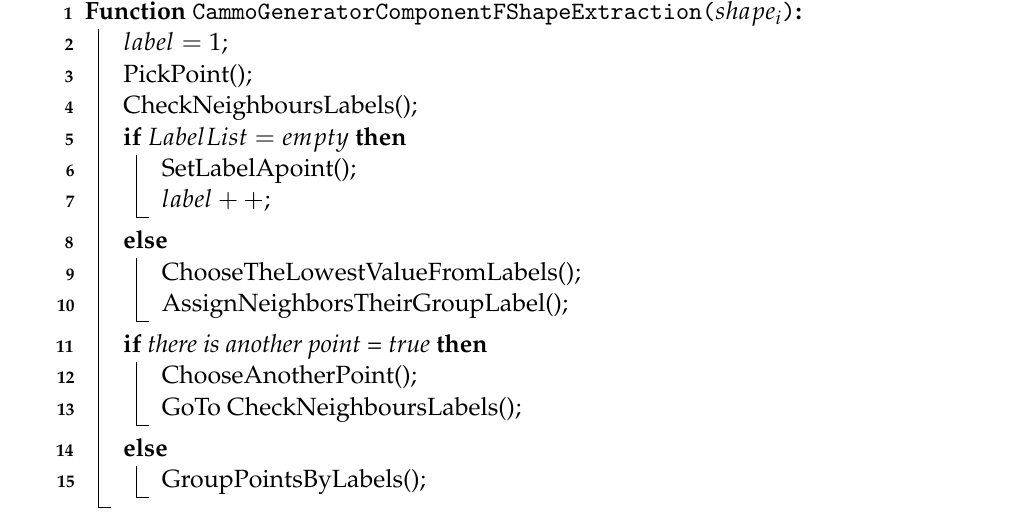
Algorithm 2: CammoGenerator component—shape extraction function.